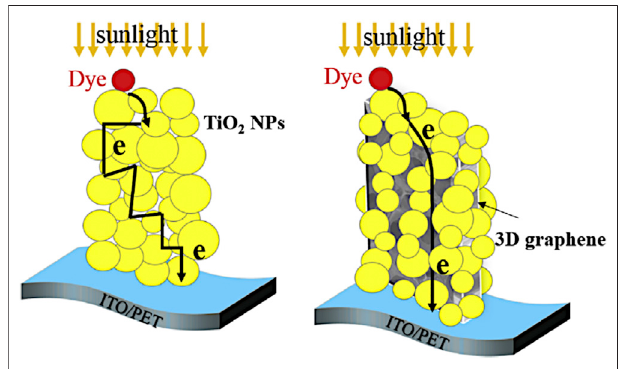
FIGURE15| Schematic illustration ofthedevicesand electron transport path without and with graphene (ITO-indium tin oxide; PET-polyethylene terephthalate) (Zhi et al.,